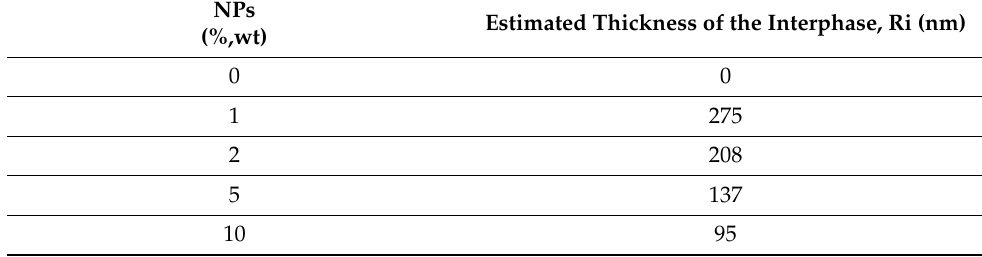
Table 5. The estimated thickness of the interphases, Ri, in nanometers, as calculated using the model reported in reference [49]. NPs Estimated Thickness of the Interphase, Ri (nm) (%,wt) 0